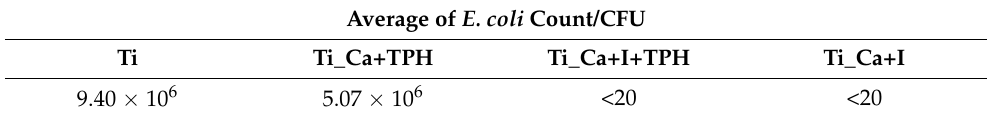
Table 3. Antibacterial activity values of S1_Ti against E. coli